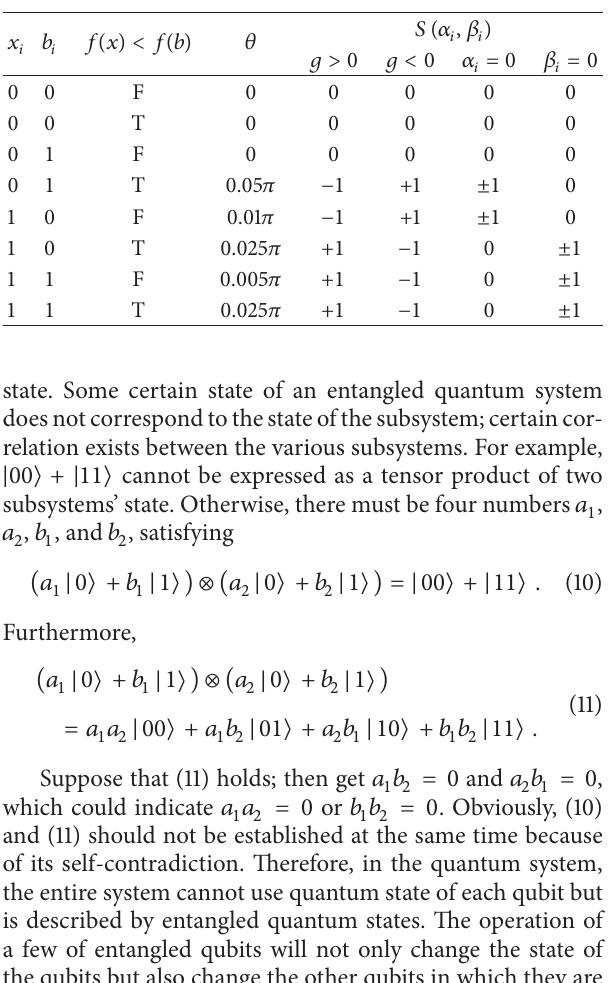
Table 1: Adjustment strategy of the quantum rotation